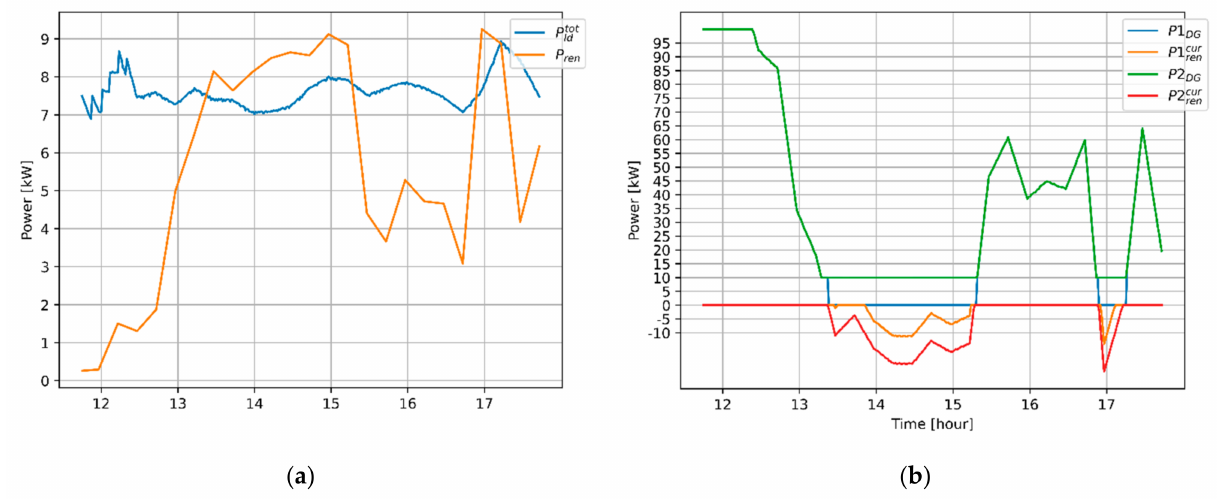
Figure 16. Test results of Case-b: ( a ) The load and generation through tests of Case-b. ( b ) Resultant DG power and curtailed renewable power of the proposed dispatch function and the dispatch function developed by Sun et al. in [25].